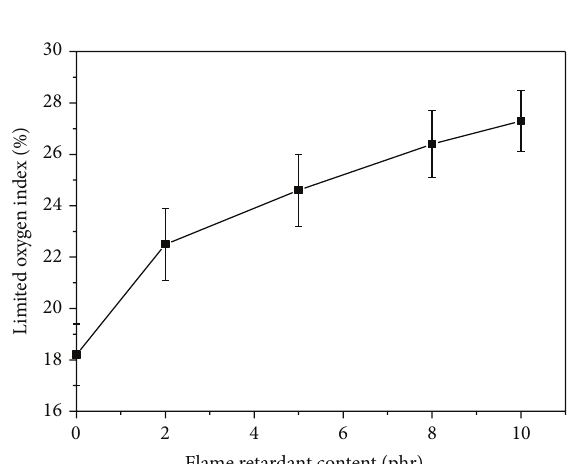
pure RPUF, the PHRRs were decreased by 24.2%, 31.9%, 32.0%, and 39.4%, respectively. The total heat release in the combustion of pure RPUF in 250 s was 31.6 MJ/m −2 . After 2, 5, 8, and 10 phr of DPTP were added, the correspond- ing values of the total heat release during the combustion of RPUF in 250 s were 22.5, 24.3, 21.0, and 23.4 MJ/m respectively, showing a comparative decrease of 28.8%, 23.1%, 33.5%, and 25.9%, respectively. This suggests that the addition of DPTP can significantly reduce the exothermic effect and mass loss rate of RPUF during combustion. However, the introduction of DPTP shortens the ignition time of the composite material, since the thermal decomposition tem- perature of DPTP is lower than that of RPUF macromolecular chains and DPTP has a lower thermal stability. One apparent feature in the combustion of RPUF is that a large amount of thick black smoke is generated. The smoke contains both thermal decomposition products and combustion